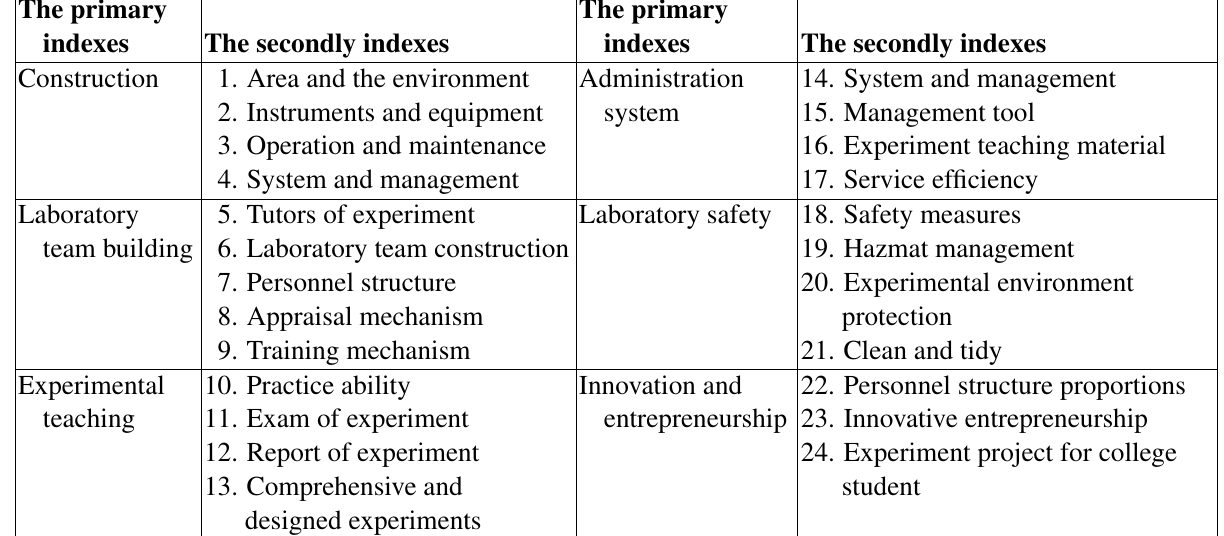
Table 1 Evaluation system of college